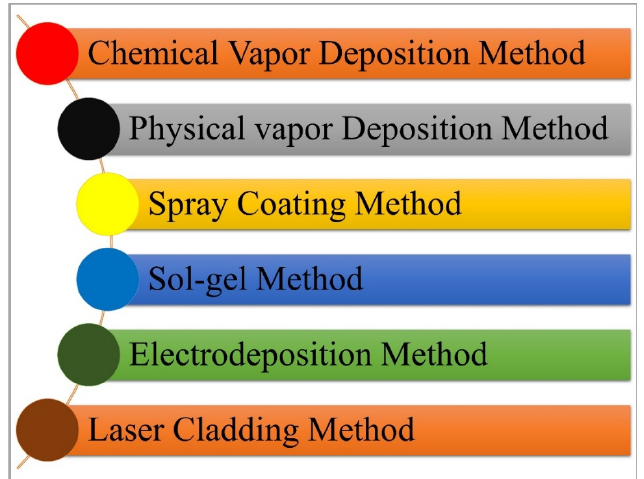
Figure 1. Different methods to produce nanostructured coatings.